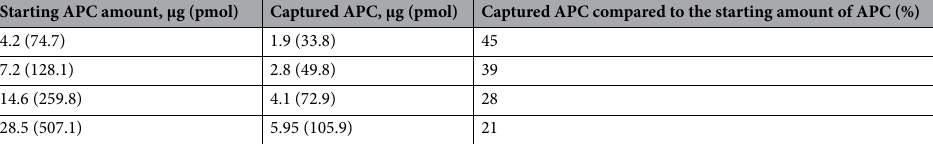
Starting APC amount, µg